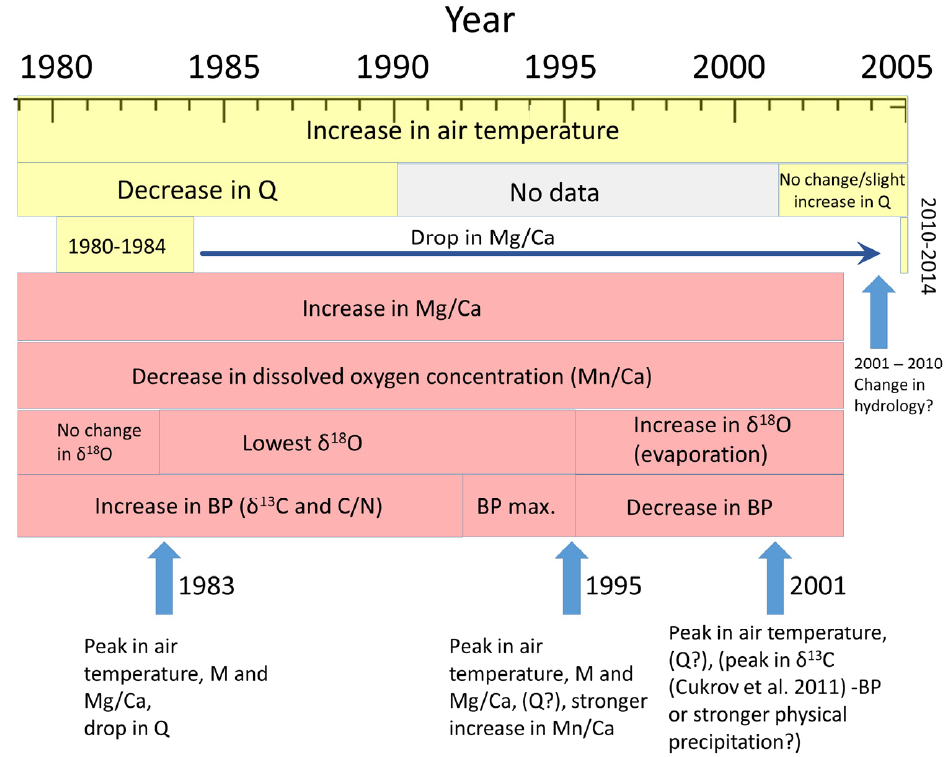
Figure 8. Chronological diagram comparing measured air temperature, water discharge (Q) [81], and Mg/Ca ratio in water [8] (in yellow) to elemental and isotope composition in the tufa (in pink), with presumable processes taking place (BP—bioproduction, M—element concentration, Cukrov et al. 2011 [68]). Blue arrows point to the peak events in the Korana River tufa. This implies that in the research area (the water around tufa, and the tufa itself), environmental changes such as higher air temperature and a decrease in water recharge cause a decrease in dissolved oxygen concentration as well as an increase in bioproductivity, which can, however, with increased evaporation, lead to a decrease in bioproductivity on account of physical calcite